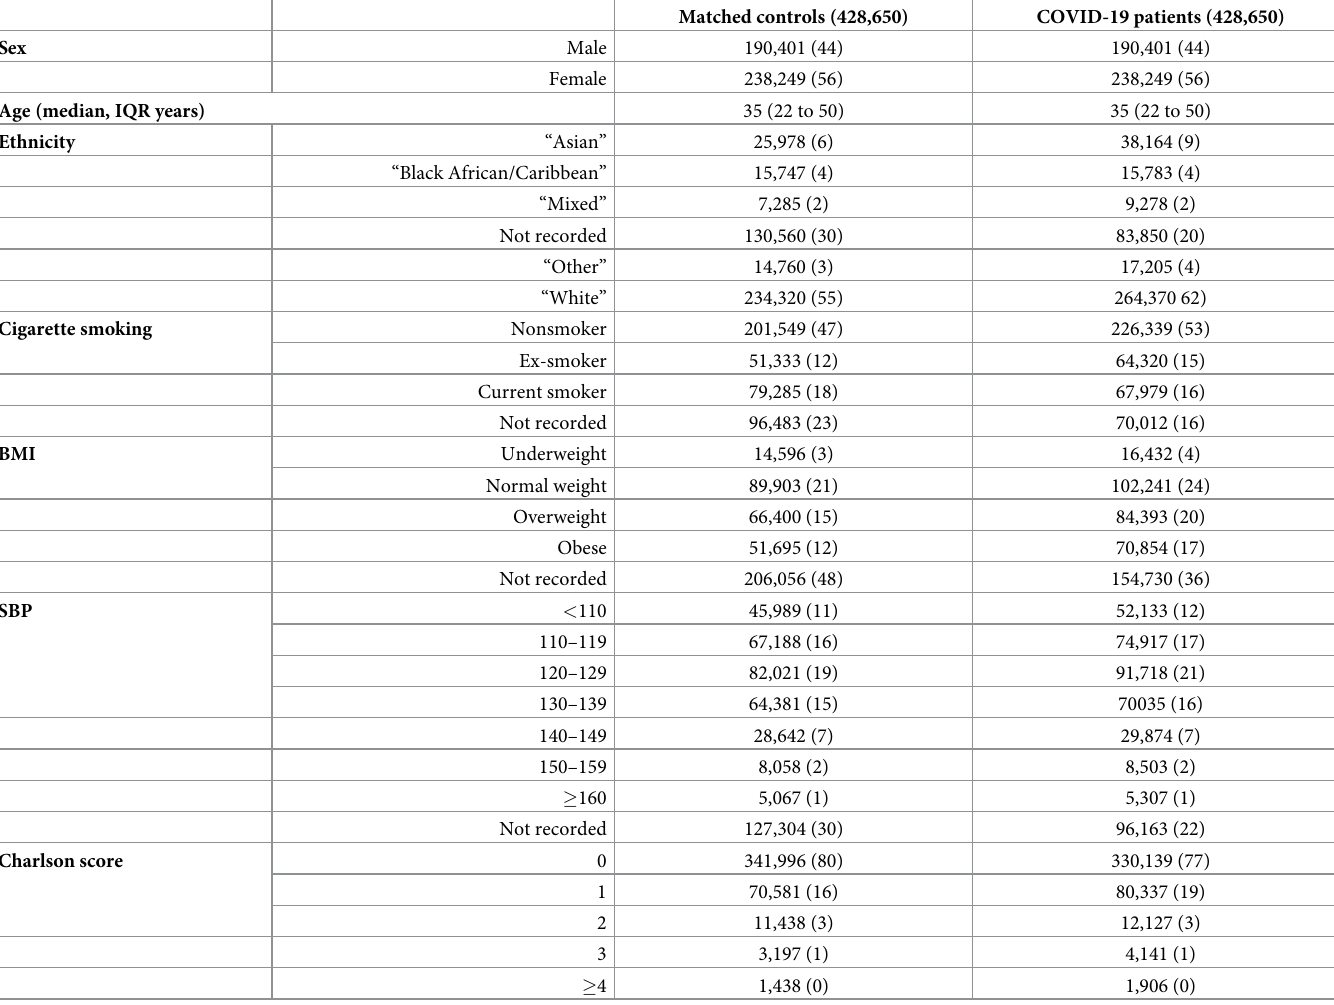
Table 1. Characteristics of COVID-19 and matched control participants. Figures are frequencies (percent of column